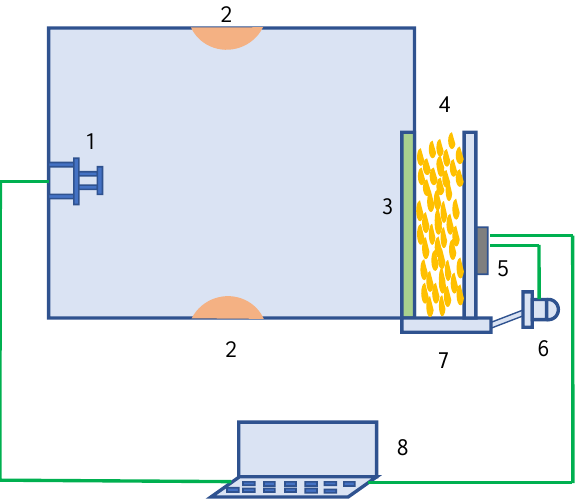
Figure 1. Schematic diagram of online detection device for impurities. Note: 3, transparent acrylic plate. 1, image sensor. 2, LED light. 4, Corn. 5, Main controller. 6, Drive motor. 7, Baffle. 8, Computer terminal.